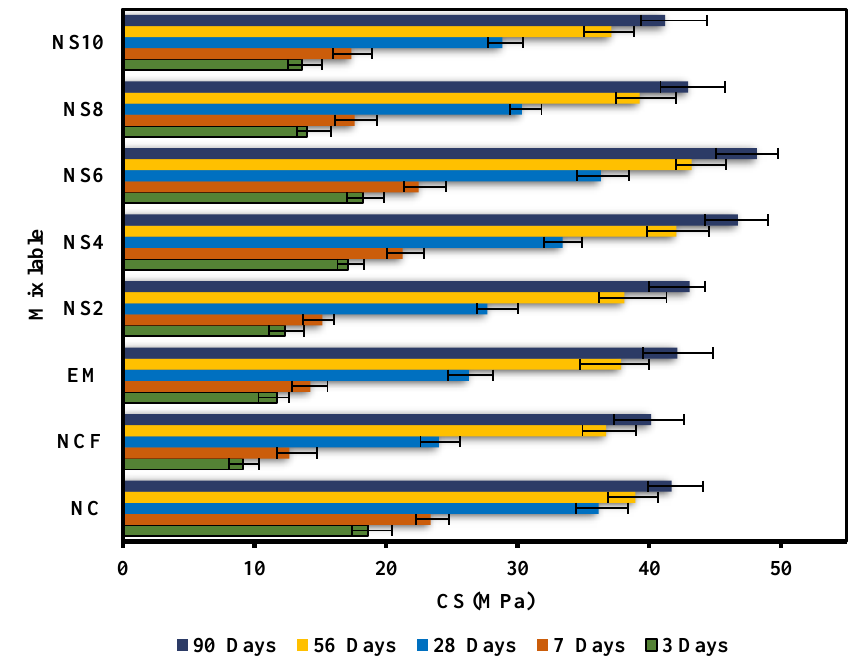
Figure 7. CS against curing periods of the proposed mixes.